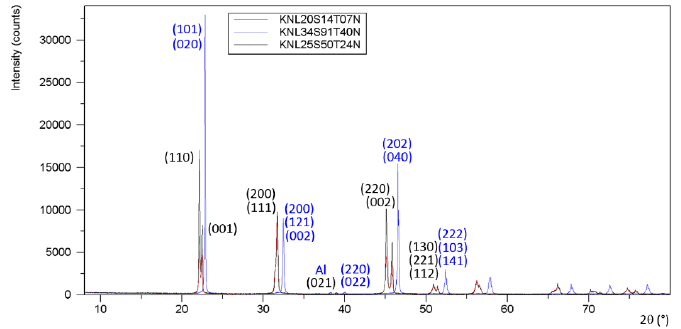
Figure 6. X-rays diffraction patterns on crushed crystals of KNL20S14T07N (attempt 1), KNL34S91T40N (attempt 2), and KNL25S50T24N (attempt 3) exhibiting an orthorhombic structure.